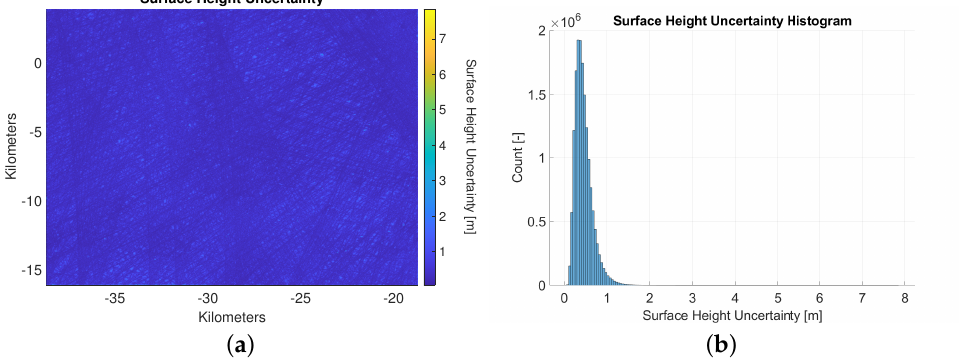
Figure 6. Surface Height Uncertainty ( σ Data ). ( a ) shows the surface height uncertainty (data from [26]) related to the data component for each pixel of the DEM (the projection is polar stereographic, where (0,0) denotes the South Pole), while ( b ) shows the histogram for all pixels shown in ( a ). Note that the scale of the x and y axes of ( a ) is not